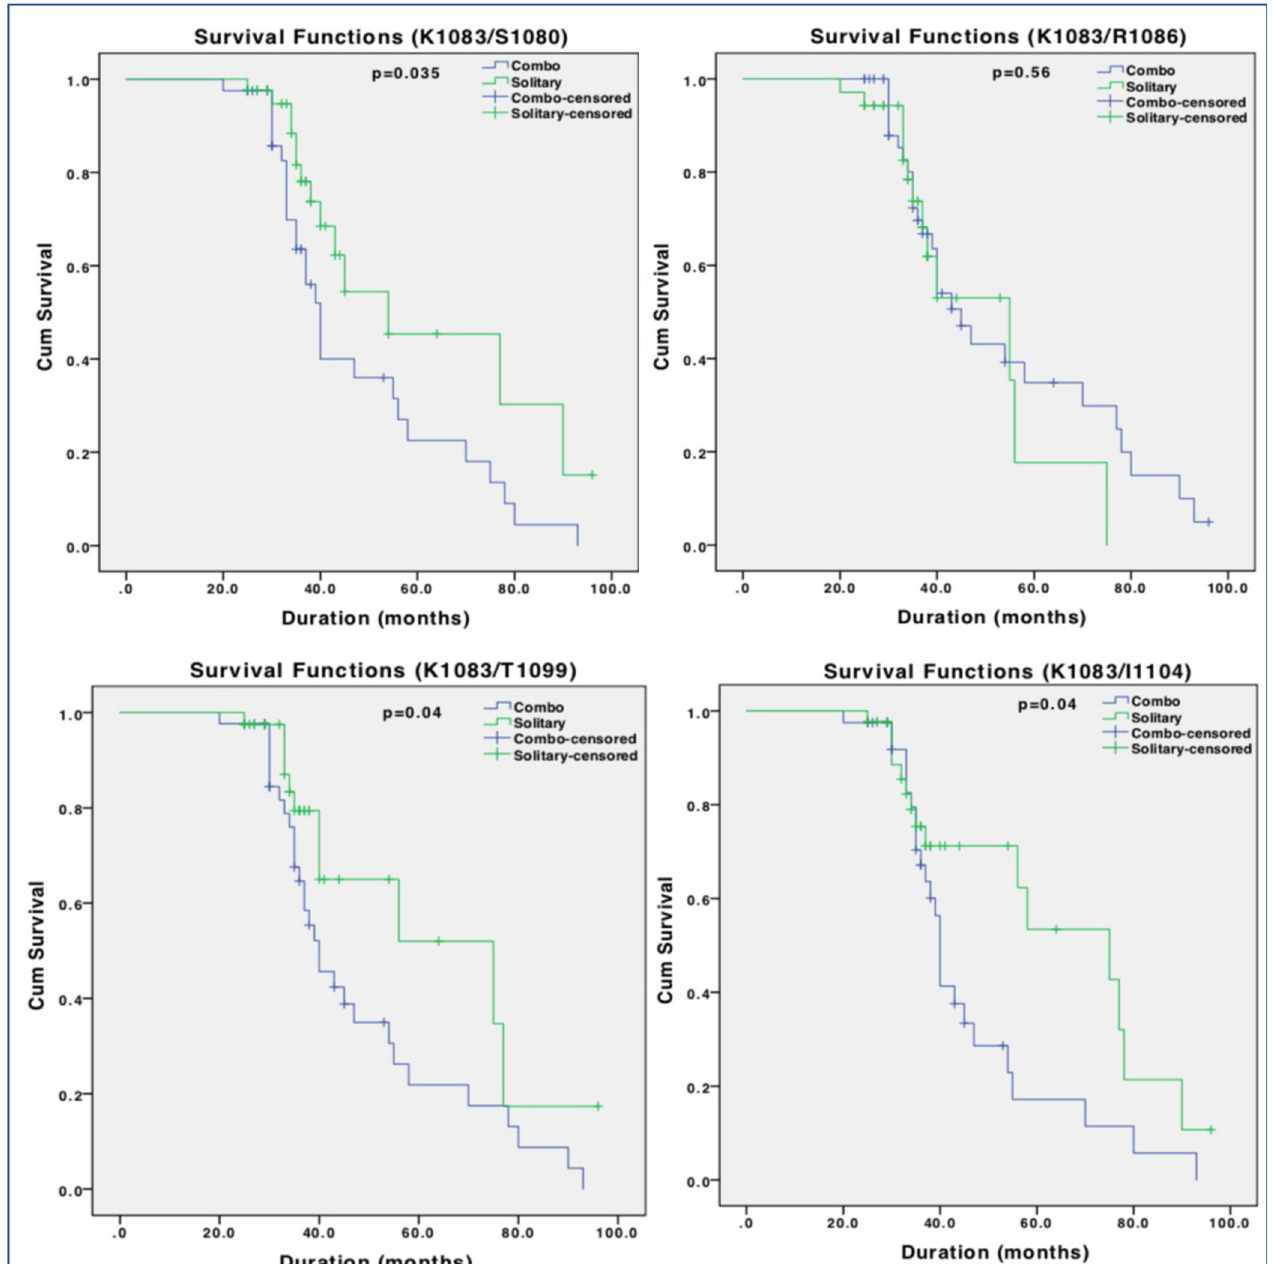
Fig 5. Impact of Rbl2/p130 C-terminus mutations on survival. Survival analysis for patients carrying K1083 mutation only (Solitary) and with other mutations (S1080, R1086, T1099 and I1104) was performed through Kaplan Meier. Except R1086, all other mutations when co-occurring with K1083 were associated with poor survival